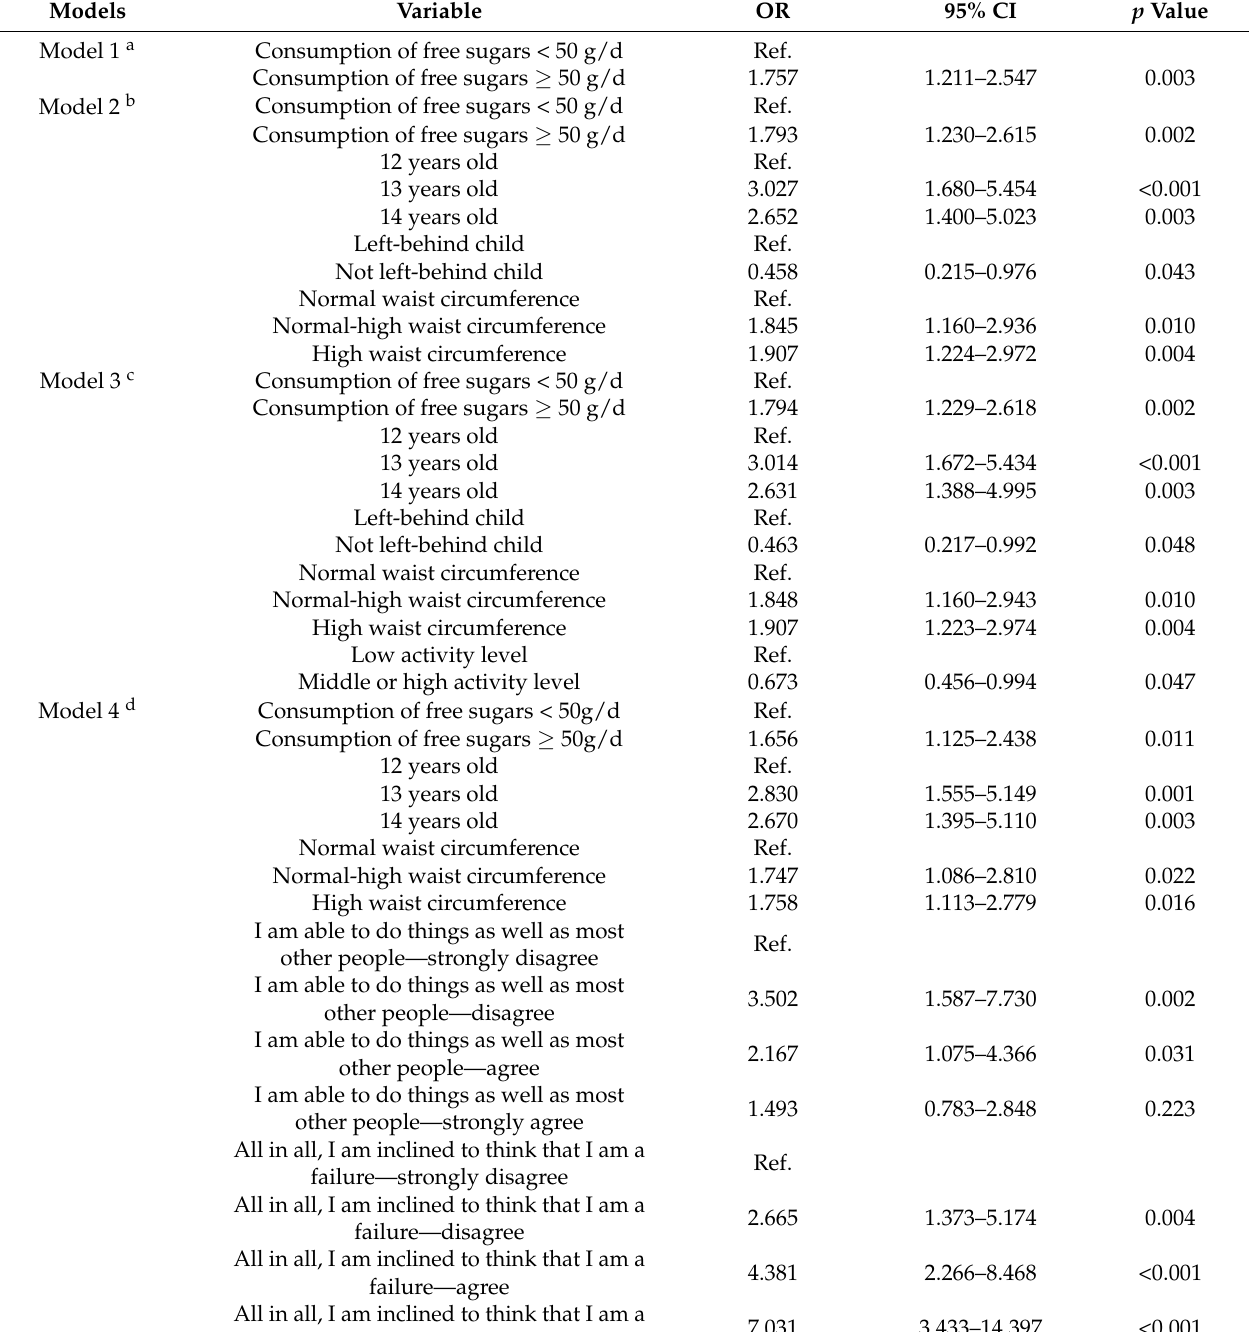
Table 3. Association between laryngopharyngeal reflux condition and free sugars consumption ( n = 1517).